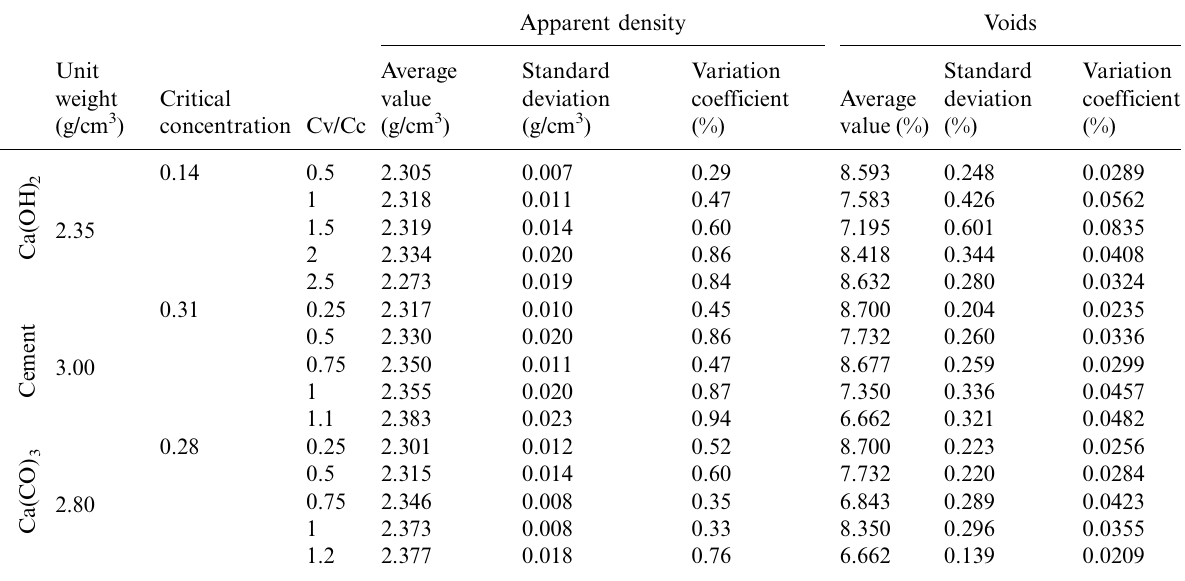
Table 2. Results obtained from the different samples